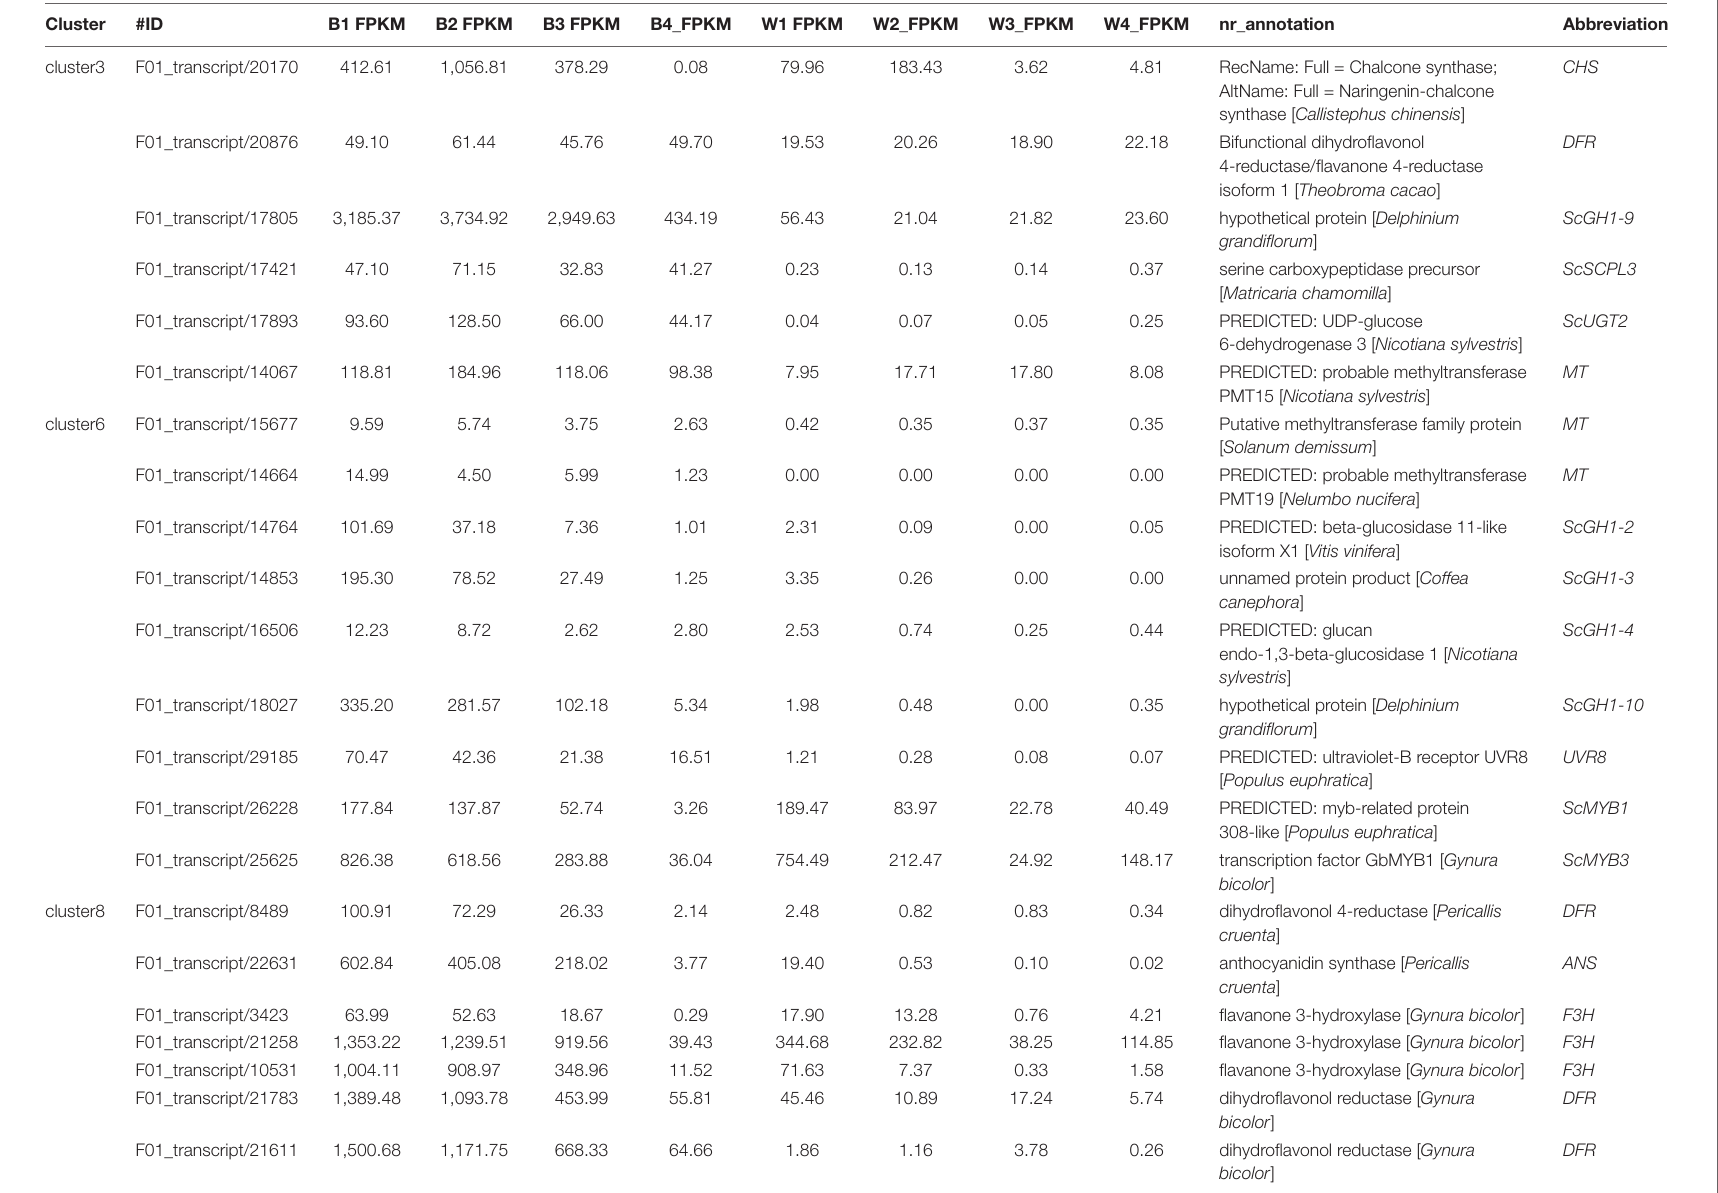
TABLE 1 | Stuctural genes and transcription factors associated with anthocyanin metabolism in 3, 6, and 8 clusters.